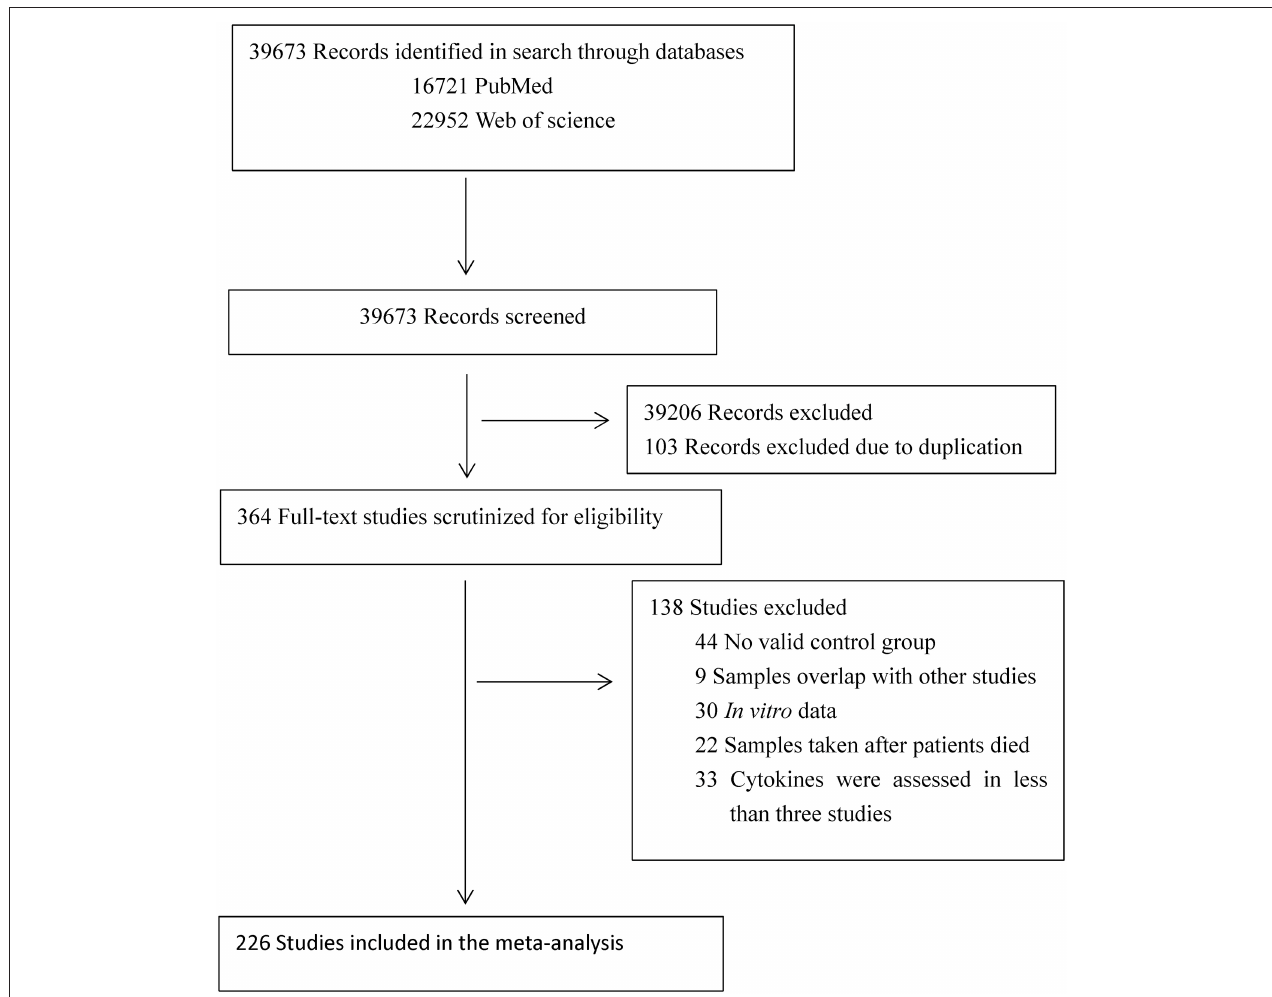
FIGURE 1 | PRISMA flowchart of the literature